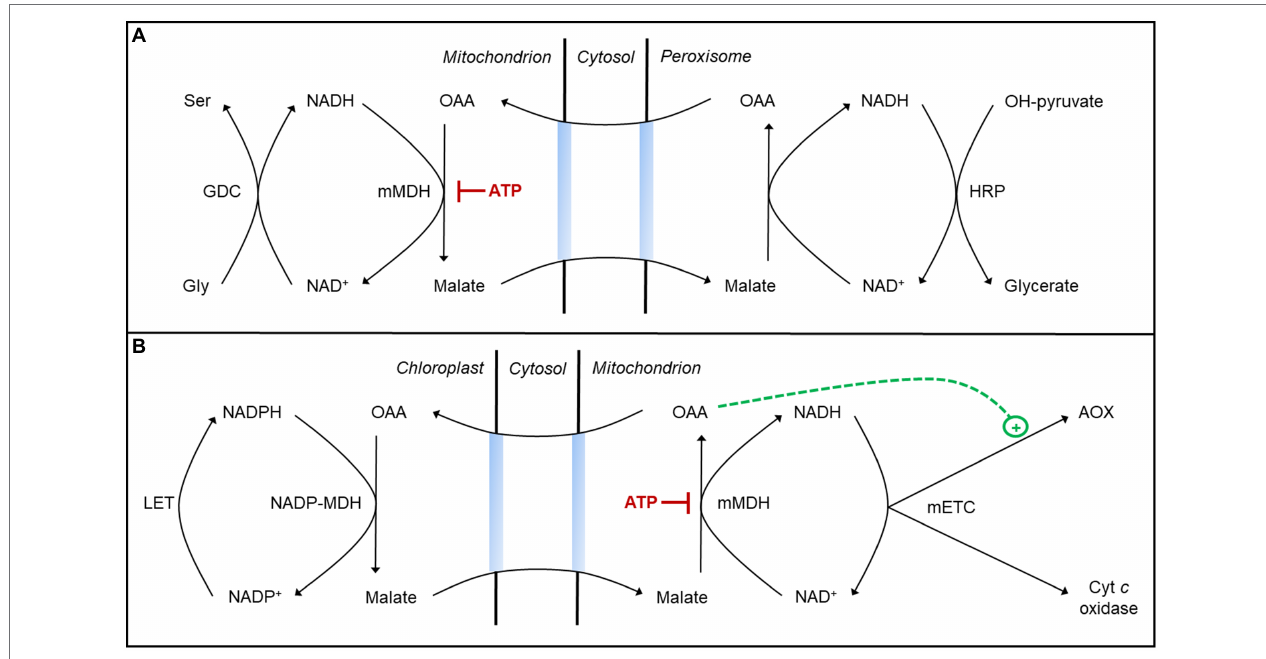
FIGURE 2 | Malate valves may aid in managing the redox state of different NAD(P)H pools during photosynthesis. (A) Some reducing equivalents (NADH) generated during photorespiratory glycine oxidation in the mitochondrion may move to the peroxisome via a malate valve to support hydroxypyruvate (OH-pyruvate) reduction to glycerate (Tomaz et al., 2010; Lindén et al., 2016; Lim et al., 2020). This process requires oxaloacetic acid (OAA) reduction to malate by a mitochondrial malate dehydrogenase (mMDH), whose activity is subject to inhibition by ATP (see text for details). (B) Some reducing equivalents (NADPH) generated by linear electron transport (LET) in the chloroplast may move to the mitochondrion via a malate valve and be oxidized by the mitochondrial electron transport chain (mETC; Nunes-Nesi et al., 2005; Shameer et al., 2019; Zhao et al., 2020). This process requires malate oxidation to OAA by mMDH, whose activity is subject to inhibition by ATP. Activation of AOX by OAA may ensure that NADH and ATP amounts remain low enough to favor this malate oxidation (see text for